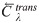
Nodal average transmission costs for four increasingly biased routing strategies.(a) Scatter plots show the transmission cost associated to each node when it acts as source (C→λtrans) and target (C←λtrans) during communication processes taking place under routing strategies generated with the values λ1, λ2, λ3 and λ4. (b) Scatter plots show the informational cost associated to each node when it acts as source (C→λinfo) and target (C←λinfo) during communication processes taking place under routing strategies generated with the values λ1, λ2, λ3 and λ4. Markers in the scatter plots in (a) and (b), representing each node, are colored according to the node’s membership in the 7 intrinsic connectivity networks (ICN) defined by Yeo et al. (2011) [71]: Visual (VIS), Somatomotor (SM), Dorsal Attention (DA), Ventral Attention (VA), Limbic (LIM), Frontal Parietal (FP), and Default Mode Network (DMN). The size of the markers is proportional to node’s strength. (c) Correlations between node strength and C→λtrans (red), C←λtrans (orange), C→λinfo (green) and C←λinfo (blue) as a function of λ. Solid lines show median correlation across all subjects, shaded areas surrounding the lines show 95th percentile. Shaded colored areas between the vertical dashed lines indicate regions where the correlations were not significant (p > 0.001). (d) Correlation between C→λtrans and C←λtrans (red), and C→λinfo and C←λinfo (blue), as a function of λ. Solid lines show medians across all subjects and shaded areas surrounding solid lines show the 95th percentile. Shaded areas between the vertical dashed lines indicate areas where correlation values were not significant (p > 0.001). In all panels, λ1 = e-4.49, λ2 = e-1.64, λ3 = e0.37 and λ4 = e1.79.